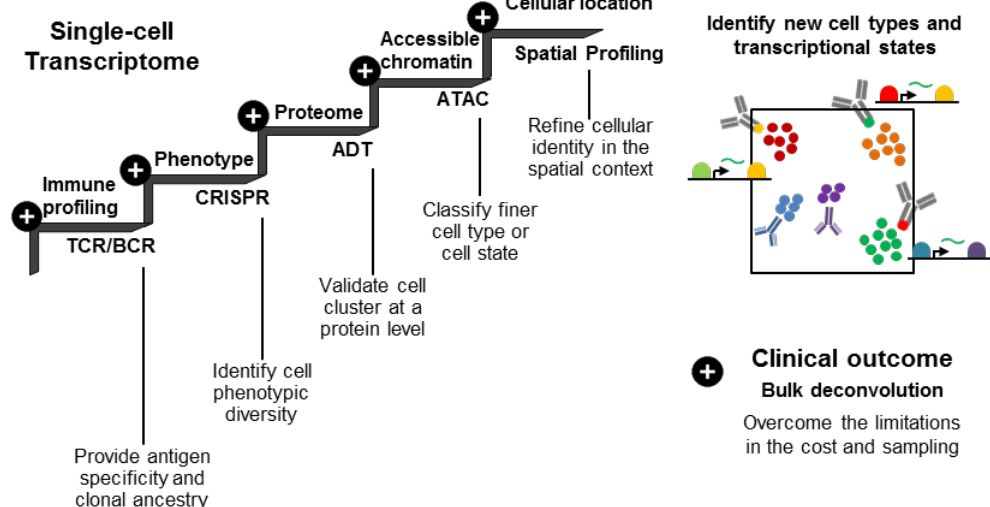
Figure 3. Integrative approaches using single-cell multi-modal omics.